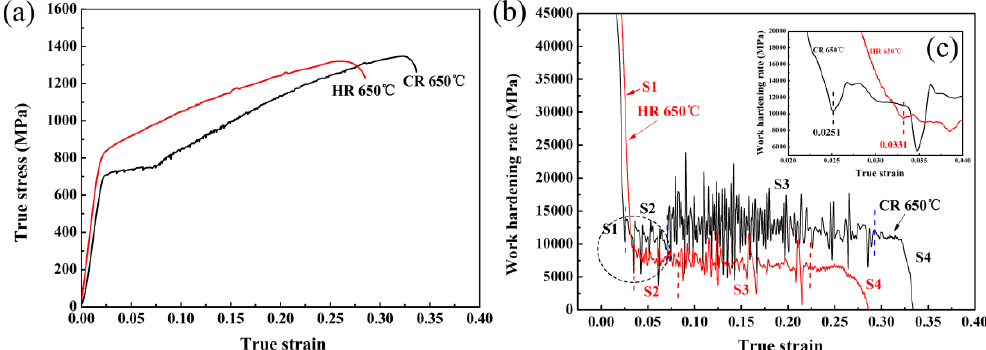
Figure 6. ( a ) True strain-stress curves, ( b ) work-hardening rate (WHR) and ( c ) partial magnification of the area indicated by black dotted circle in ( b ).